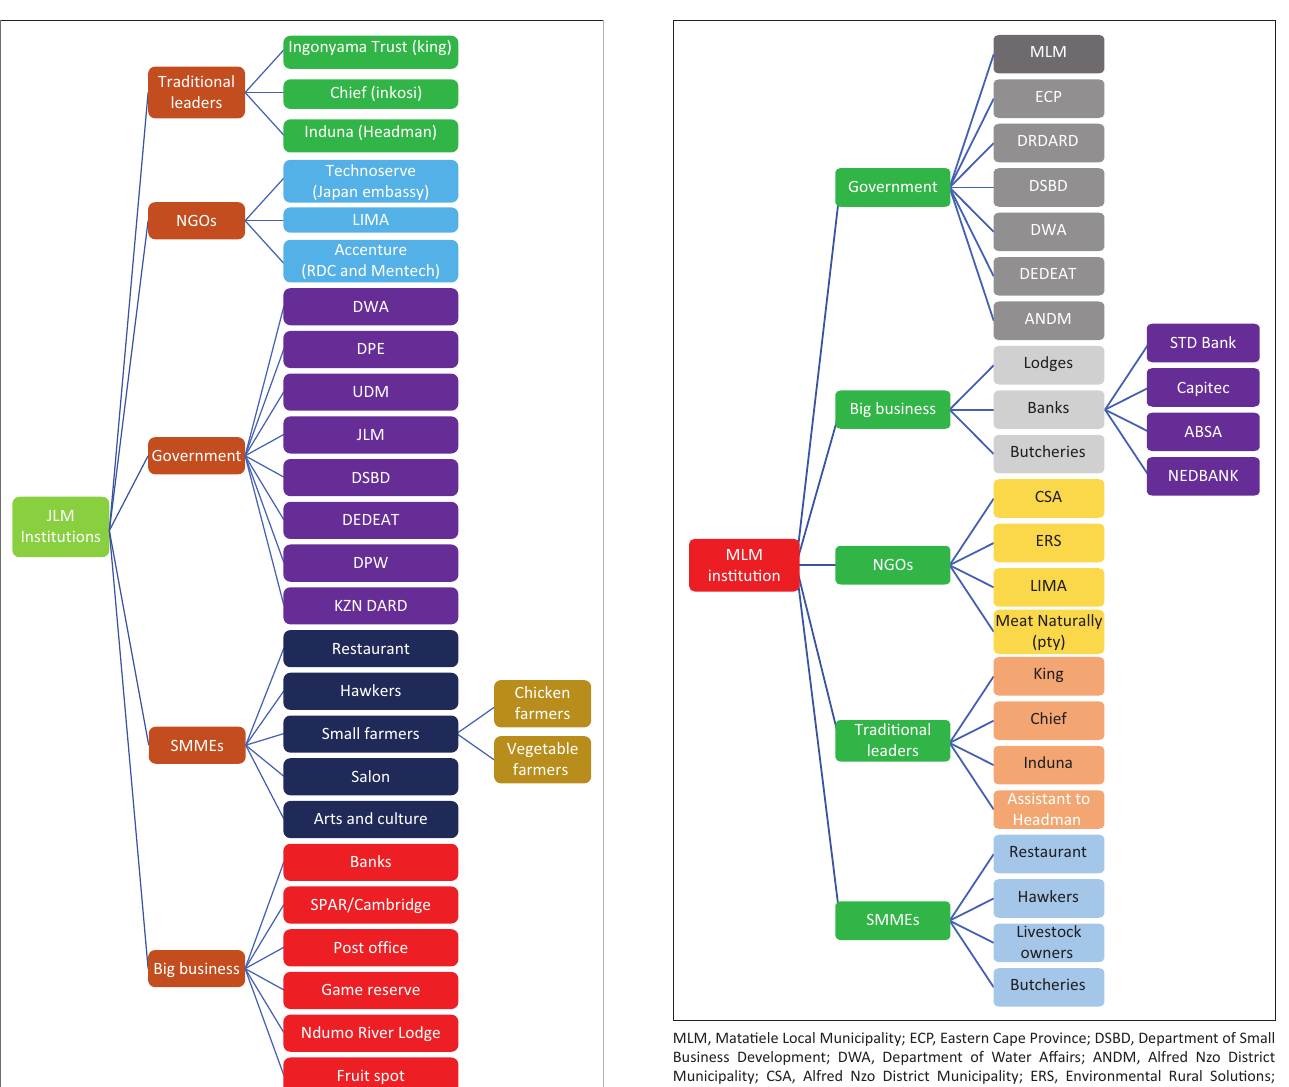
FIGURE 3: Summary of Matatiele Local Municipality’s small medium and micro enterprises social and institutional networks.